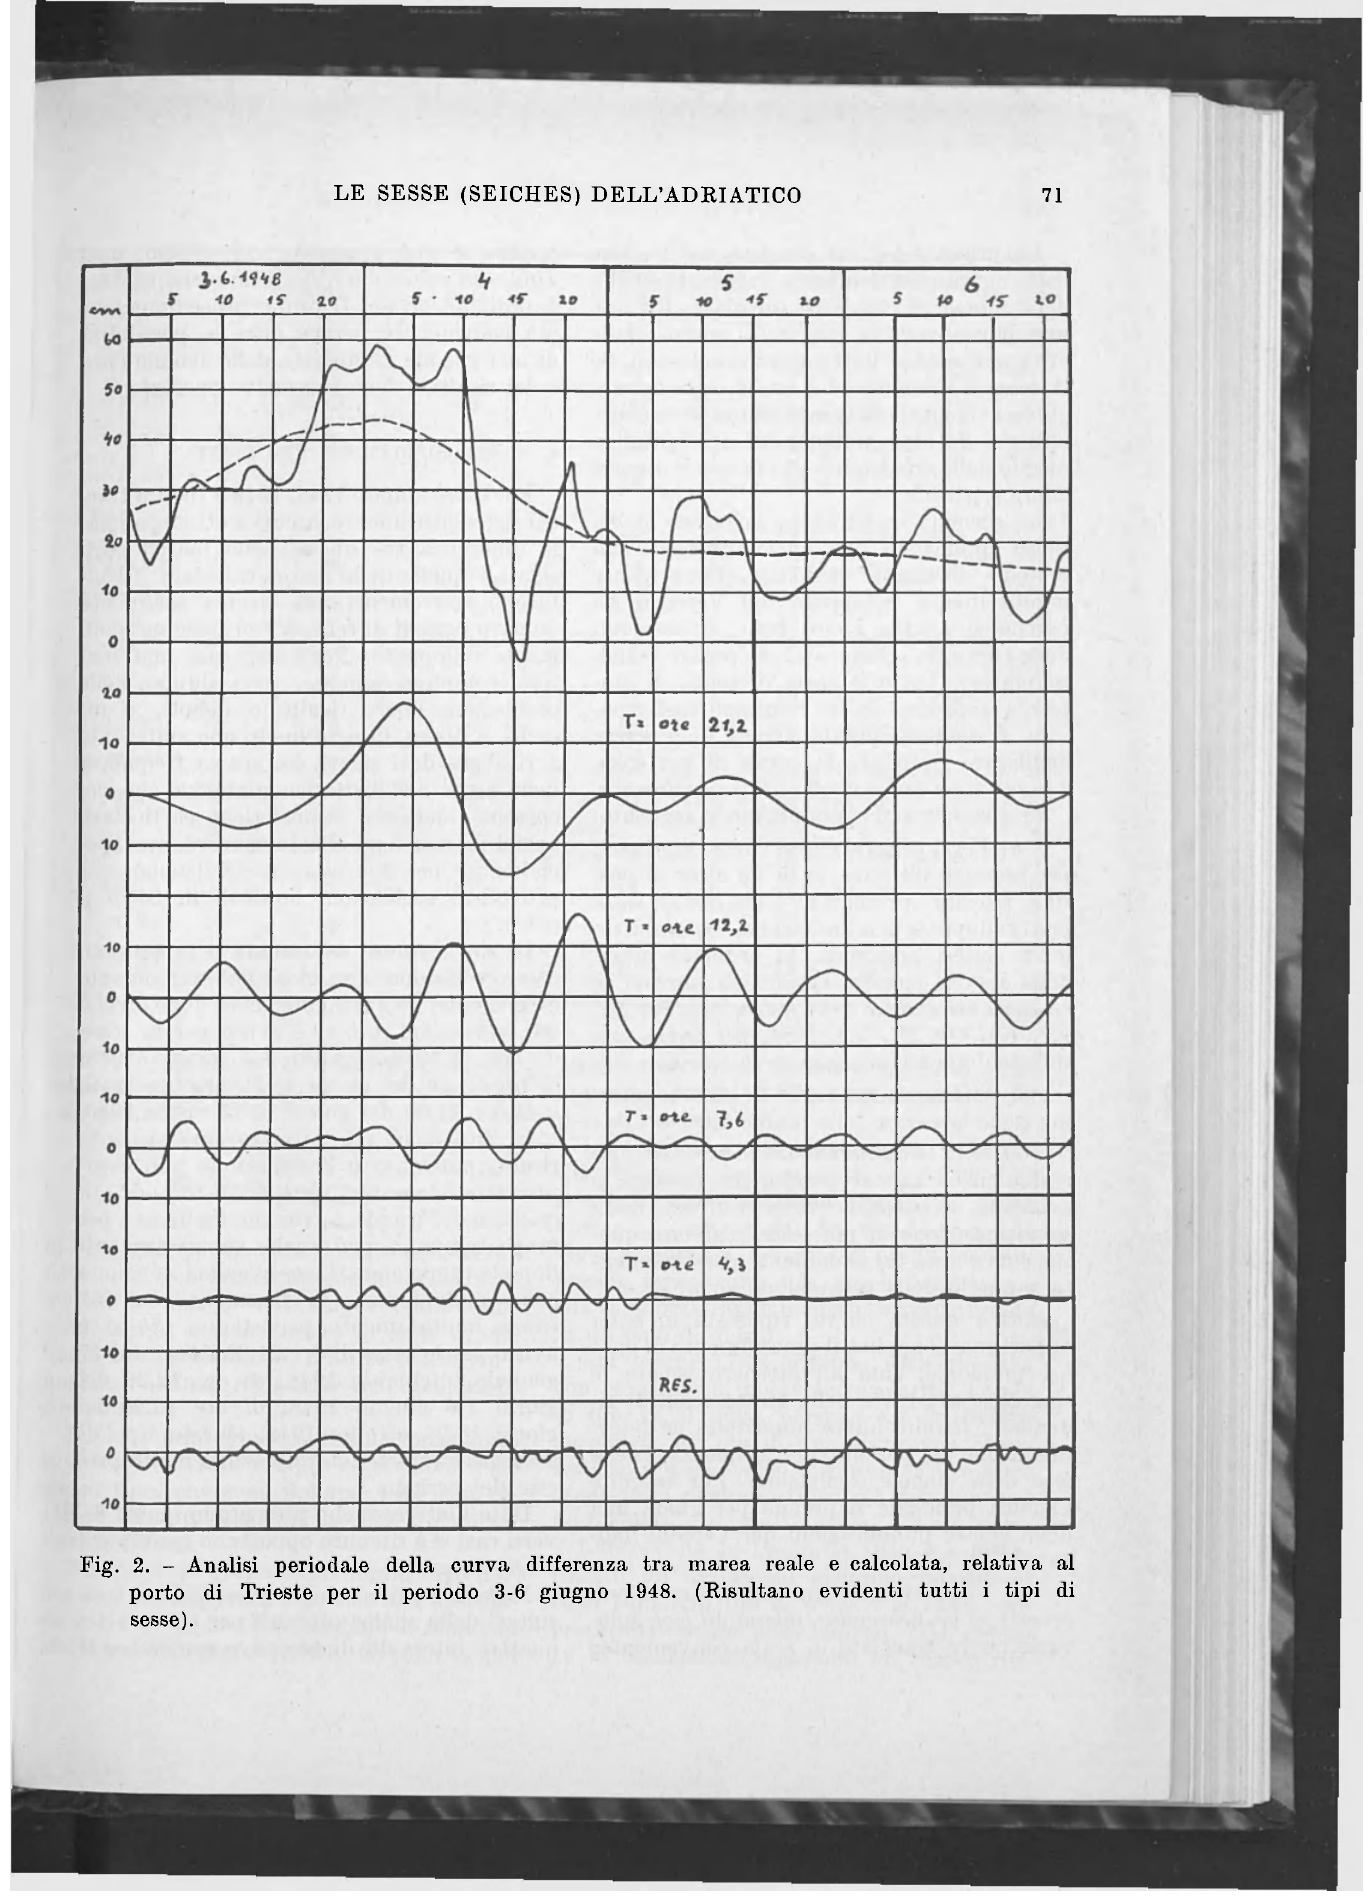
Fig. 2. - Analisi periodale della curva differenza tra marea reale e calcolata, relativa al porto di Trieste per il periodo 3-6 giugno 1948. (Risultano evidenti tutti i tipi di